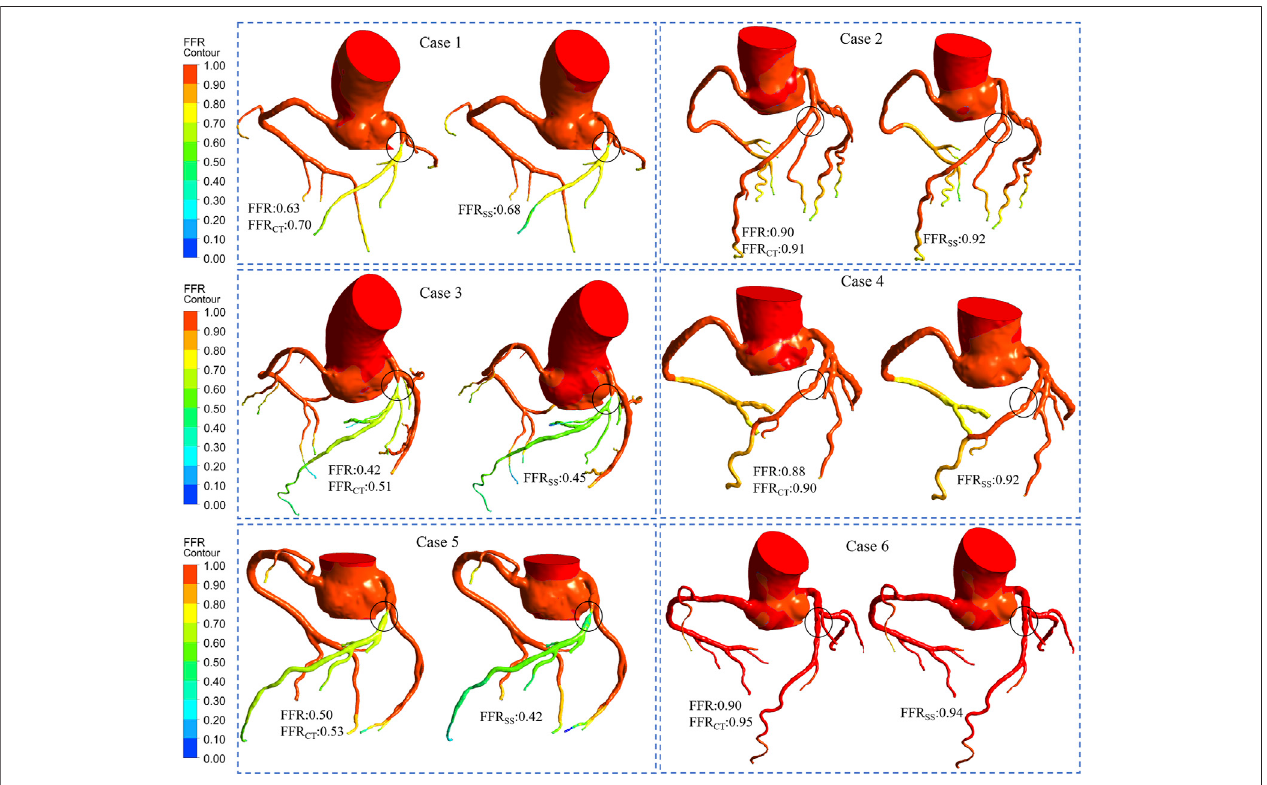
FIGURE 6 | Computed FFR contours for representative patients. Six representative patients had moderate stenosis of the left descending artery. Among them, cases1,3,and5wereischemiapatients.Cases2,4,and6werenon-ischemicpatients.TheFFR,FFR CT ,andFFR SS foreachrepresentativepatientarelistedseparately. It can be seen from the fi gure that the contours of the calculation result of FFR CT is comparable to that of FFR SS , and it have good consistency.